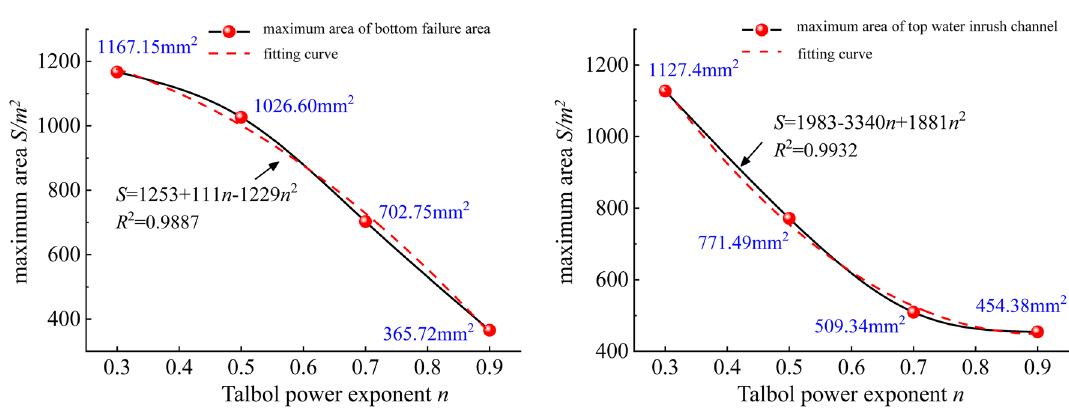
Figure 10. Relationship between the maximum area of the top water inrush channel and bottom failure area of the different graded